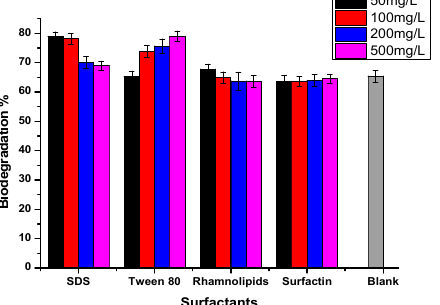
Figure 5. Crude oil biodegradation by strain BL-27 in the presence of surfactants at various concentrations. Blank means the absence of surfactants (0 mg/L).